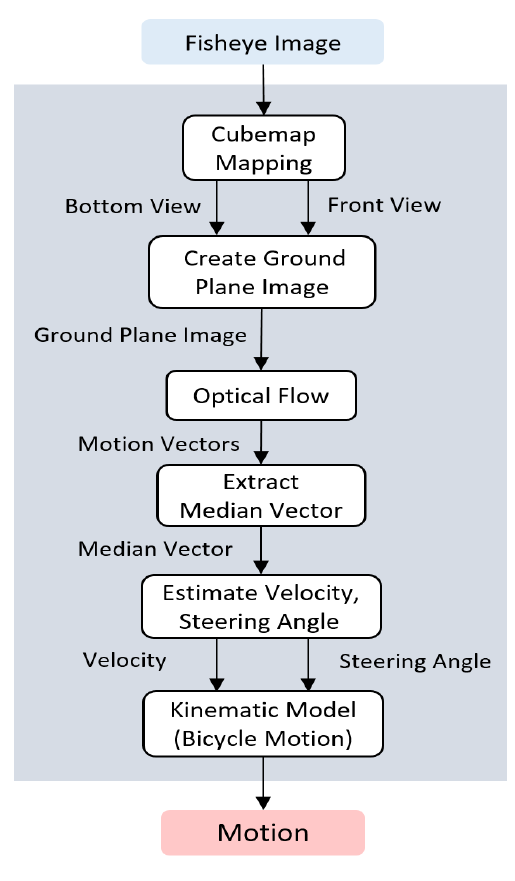
Figure 2 . Proposed total system